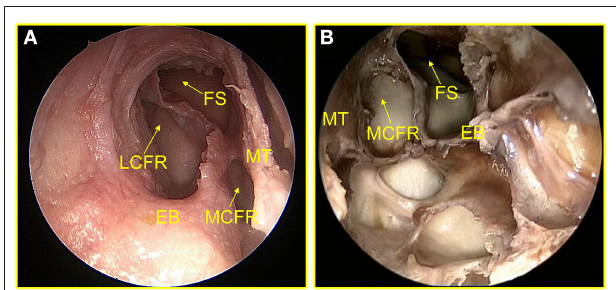
FIGURE 2 | (A) The arrow points to the ANC. (B) This sample had no ANC and only LCFR. UP, uncinate process; MT, middle turbinate; ANC, agger nasi cells; EB, ethmoid bulla; MCFR, medial cells of the frontal recess.